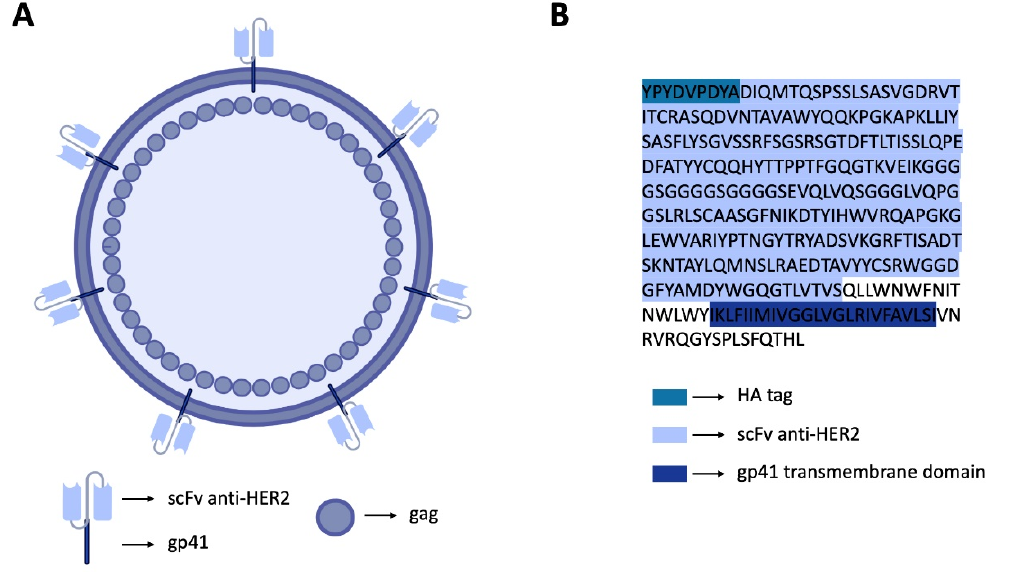
Figure 1 . Schematic illustration of the HER2-specific HIV-1-based VLP and the constructed biomimetic vector. ( A ) Illustration of the HER2-specific HIV-1-based VLP. ( B ) Amino acid sequence of the protein comprising the anti-HER2 scFv fused to HIV gp41, with a HA tag at the N-terminal.